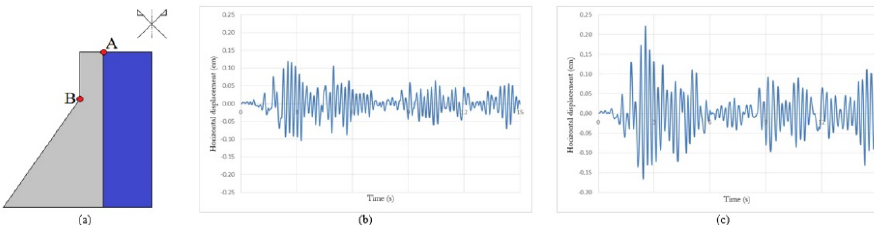
Figure 9. (a) Chosen points for the responses in the seismic analysis of the lock. Horizontal displacement in time (in cm) of the upper extreme point of the wall on the inner side of the left gravity structure of the lock (Point A) for the (b) uncoupled structural and (c) coupled fluid-structure cases.